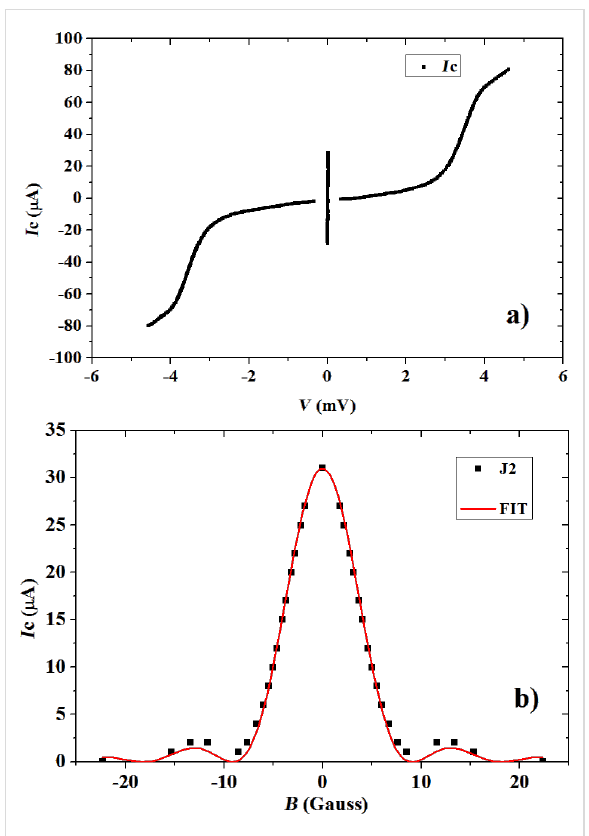
Figure 11: a) Current–voltage characteristic for NbN Josephson junc- tion and b) diffraction pattern obtained measuring J c as function of the applied magnetic field. The continuous line is a fit obtained imposing a Josephson current distribution “rounded” along the corners of the nominally square area.